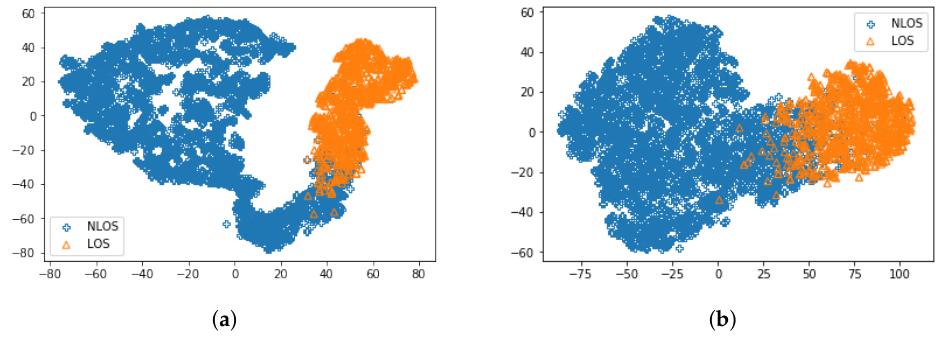
Figure 8. tSNE representation of 5000 training samples for ( a ) proposed CNNLSTM and ( b ) conventional